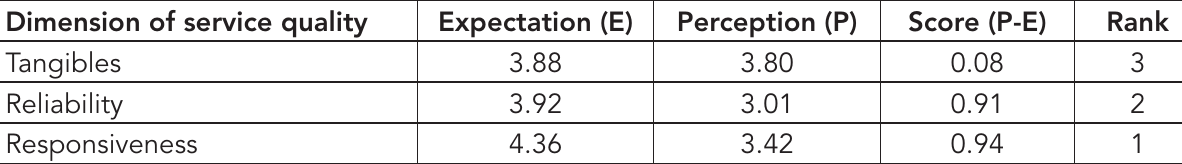
Table 2: SERVQUAL GAP